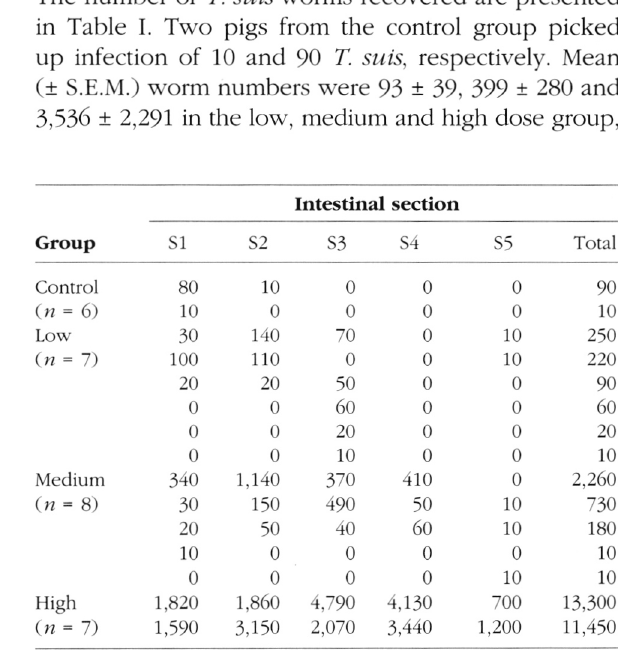
Table I. - Number of Trichuris suis recovered from the large intes­ tine of pigs inoculated with 400, 4,000 or 40,000 eggs, together with uninoculated control pigs. Only pigs harbouring T. suis at slaughter are included. S1: section 1 (caecum). S2: section 2 (0-20 % of the total length of colon). S3: section 3 (21-40 %). S4: section 4 (41- 60 %). S5: section 5 (61-100 % including rectum). Total: all five sec­ tions.